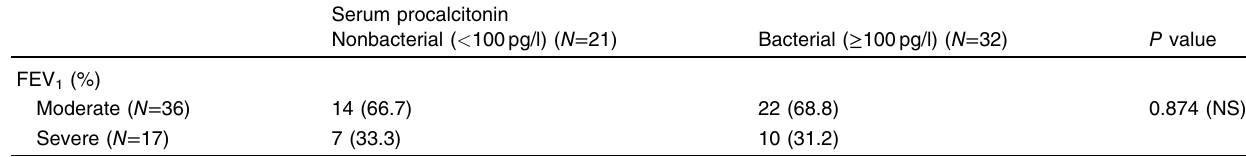
Table 21 Association between serum procalcitonin and FEV 1 (%) in the two studied groups ( N = 53)